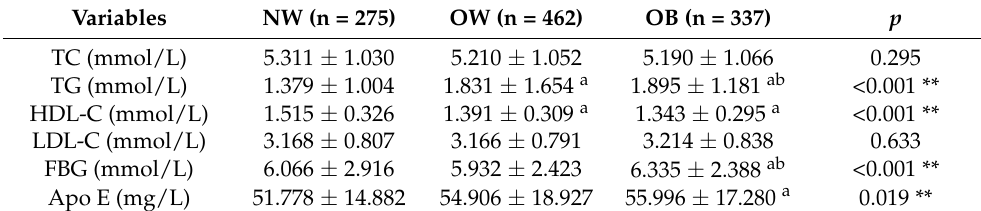
Table 2. Blood biochemistry parameters of the study population in the three